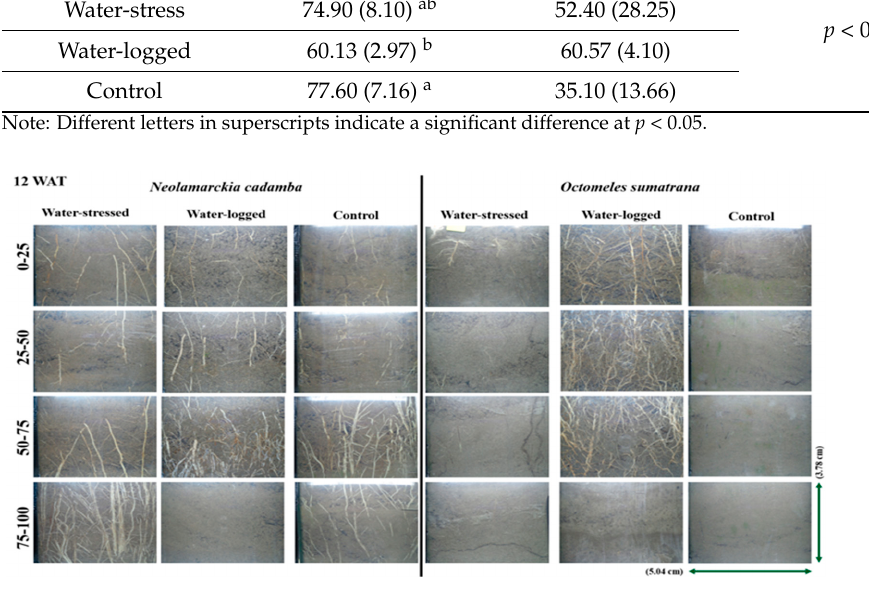
Table 6. Mean values of root depth (cm) of N. cadamba and O. sumatrana seedlings under different treatments ( n = 3) were significantly different ( p < 0.05) using two-way ANOVA followed by Tukey’s HSD post hoc.